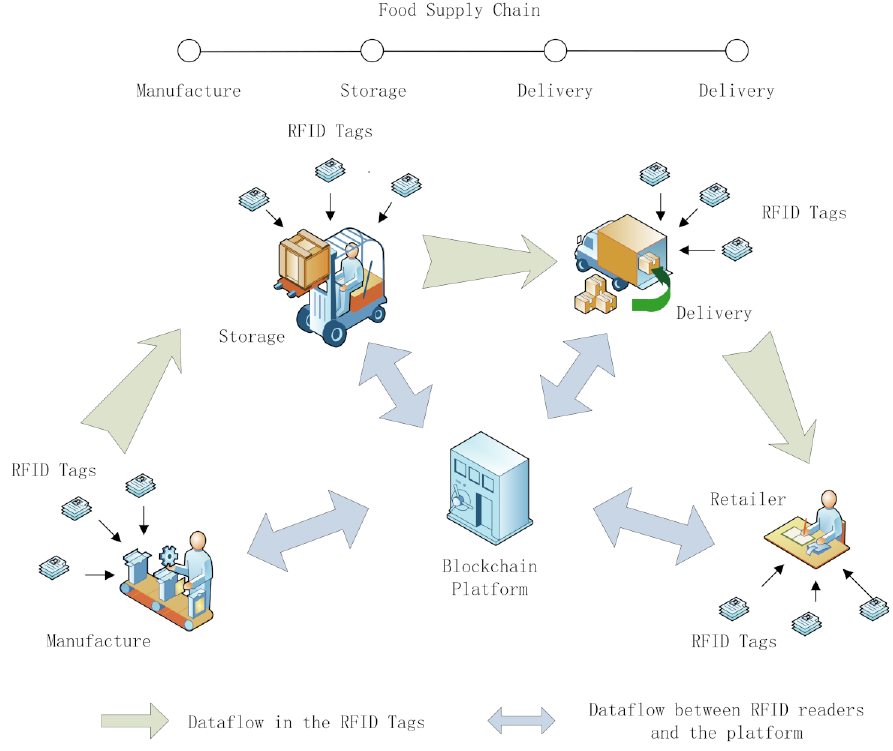
Figure 2. Application scenarios of the traceability system.